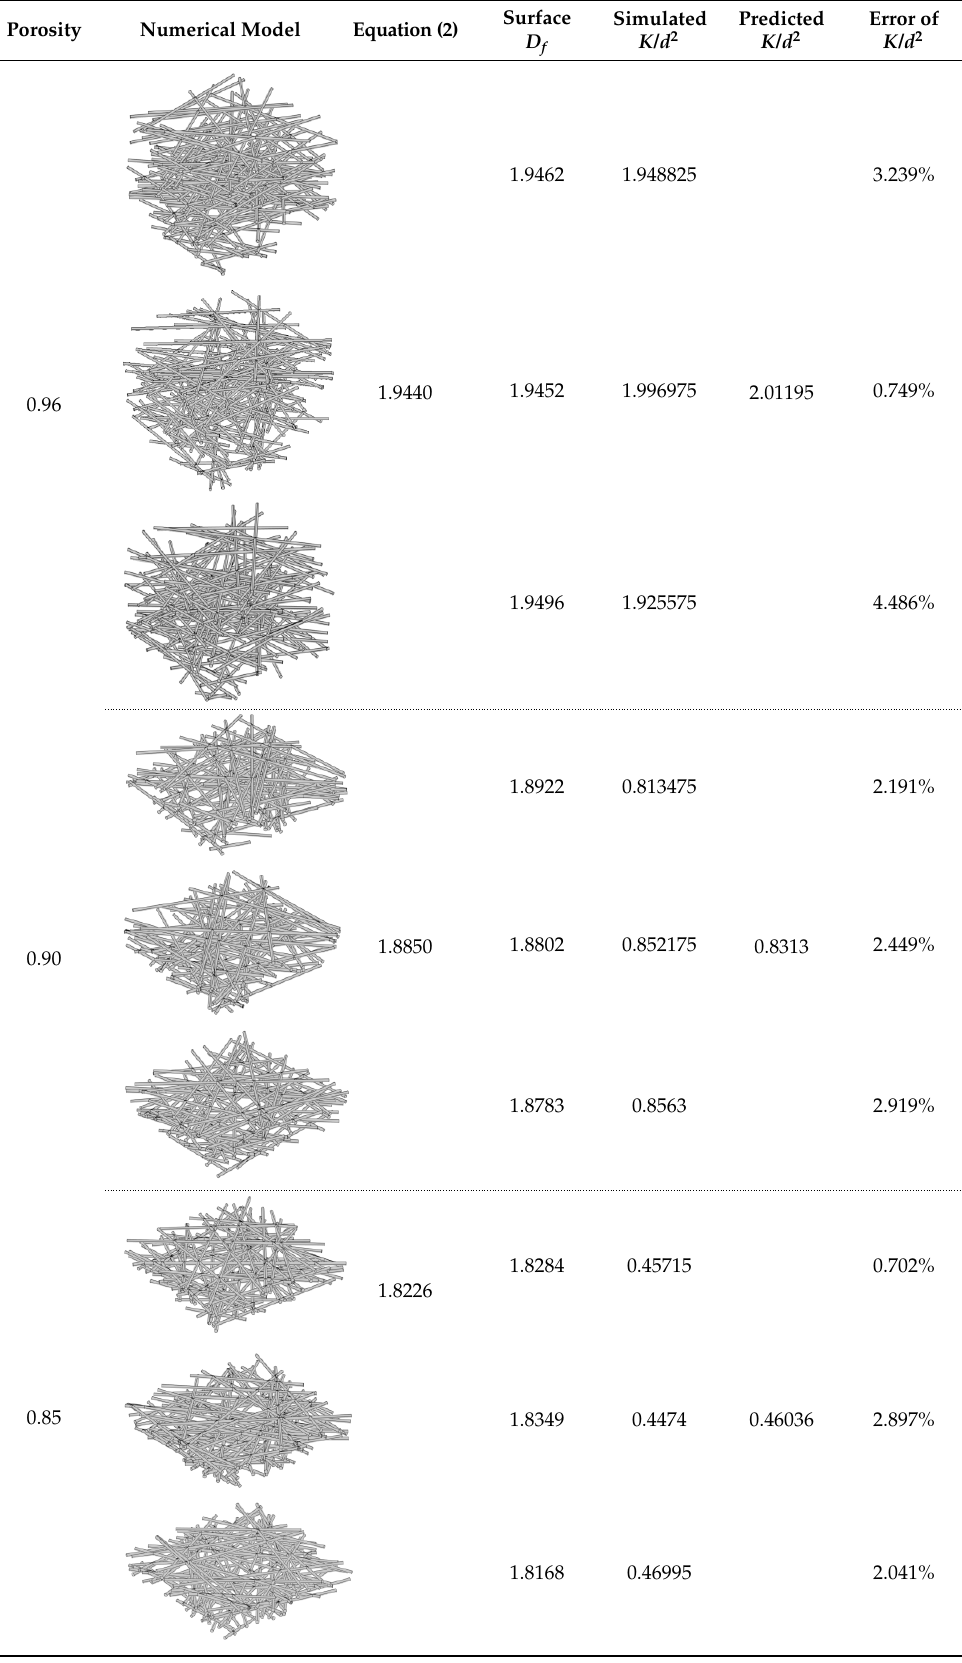
min min min min min min min